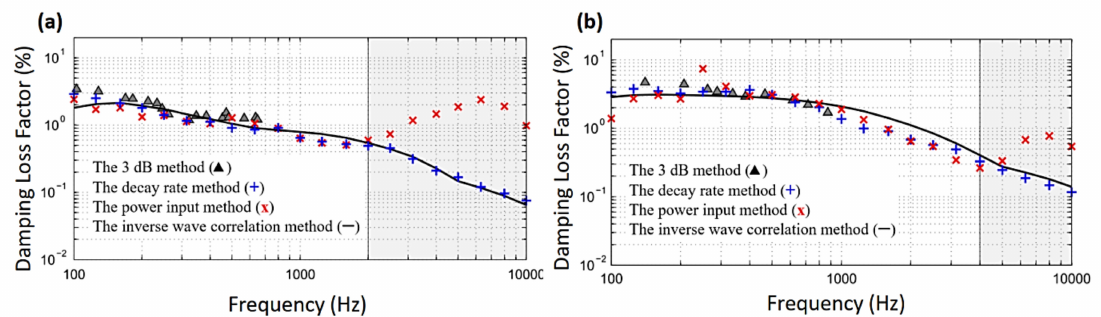
Figure 9. E ff ect of frequency on experimental damping loss factor of ( a ) a thin composite panel, ( b ) a thick composite panel